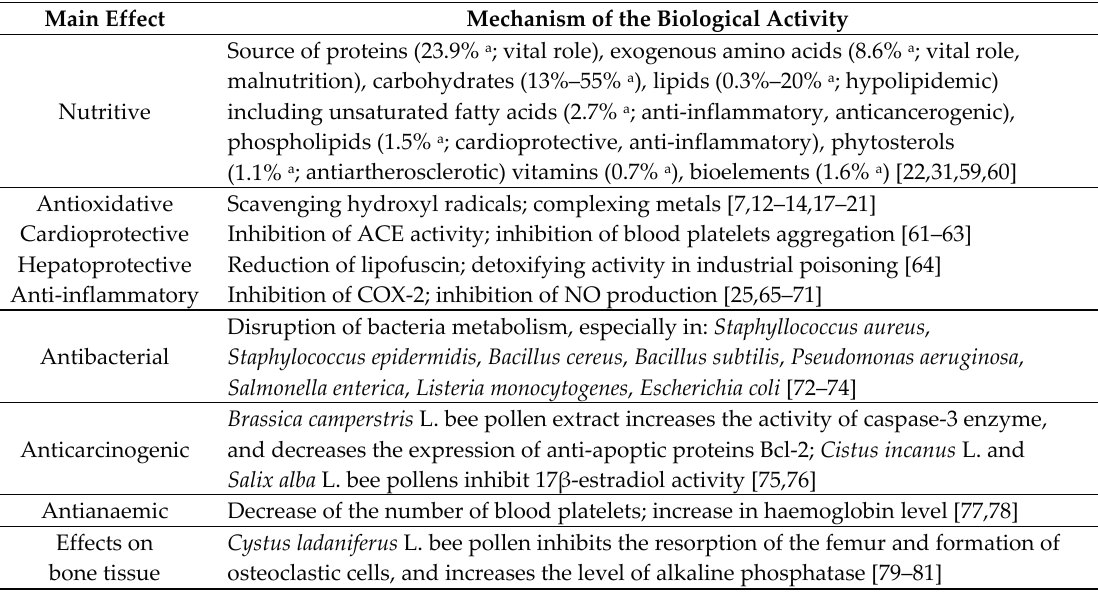
Table 2. Properties of bee